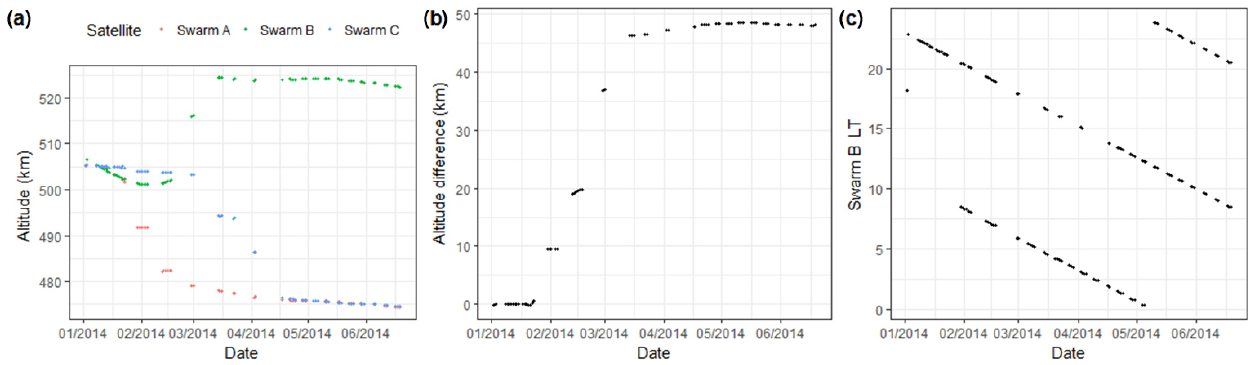
Figure 1. Variations in orbiting parameters with time. (a) Variations in orbiting altitude of the three satellites with time, (b) variations in altitude difference between Swarm B and A with time, and (c) variations in Swarm B LT with time. The orbiting altitude, altitude difference, and Swarm B (LT) in (a) , (b) , and (c) indicate the daily average values near the geographical Equator.